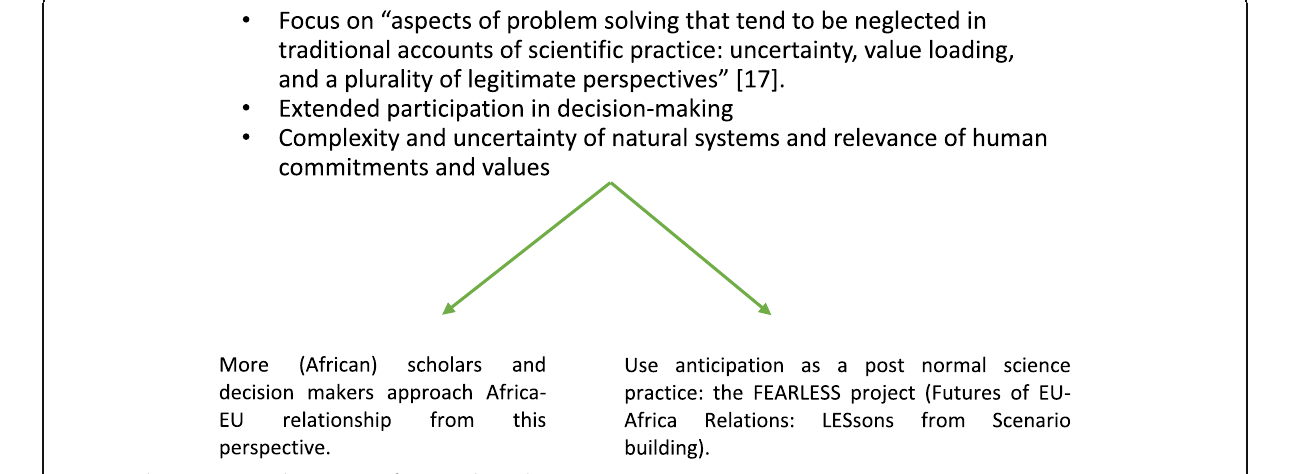
Fig. 3 Applying post-normal science to Africa-EU